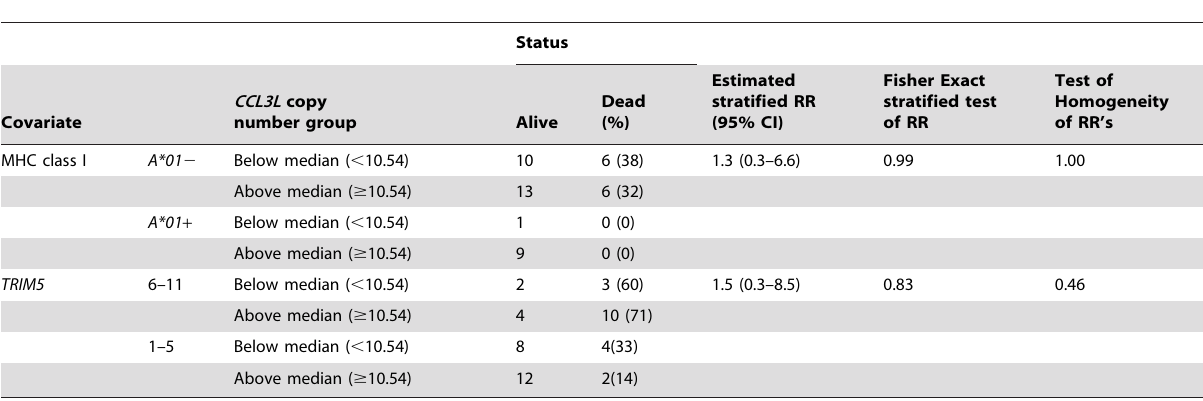
Table 5. Test of CCL3L copy number group stratified on other